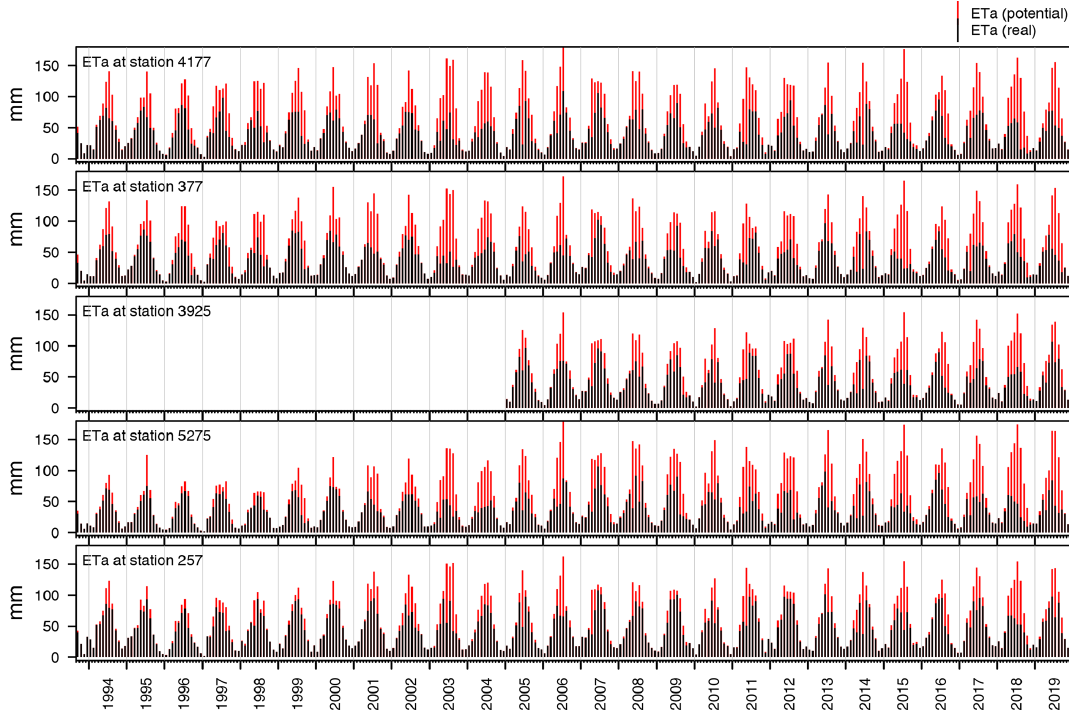
Figure A3. Potential and real evapotranspiration at five selected weather stations (DWD Climate Data Center, 2020).